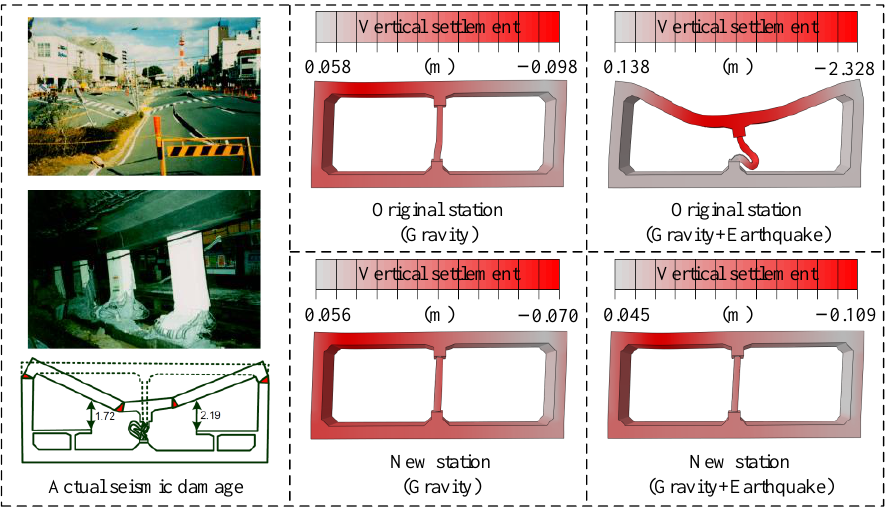
Figure 15. Comparison of actual seismic damage and numerical simulation result.